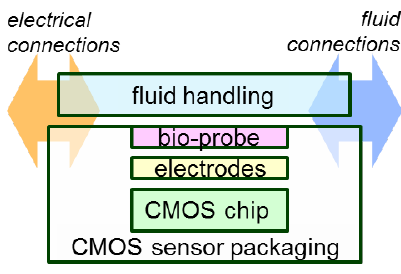
Figure 16. Components in integrating a CMOS biosensor microsystem.